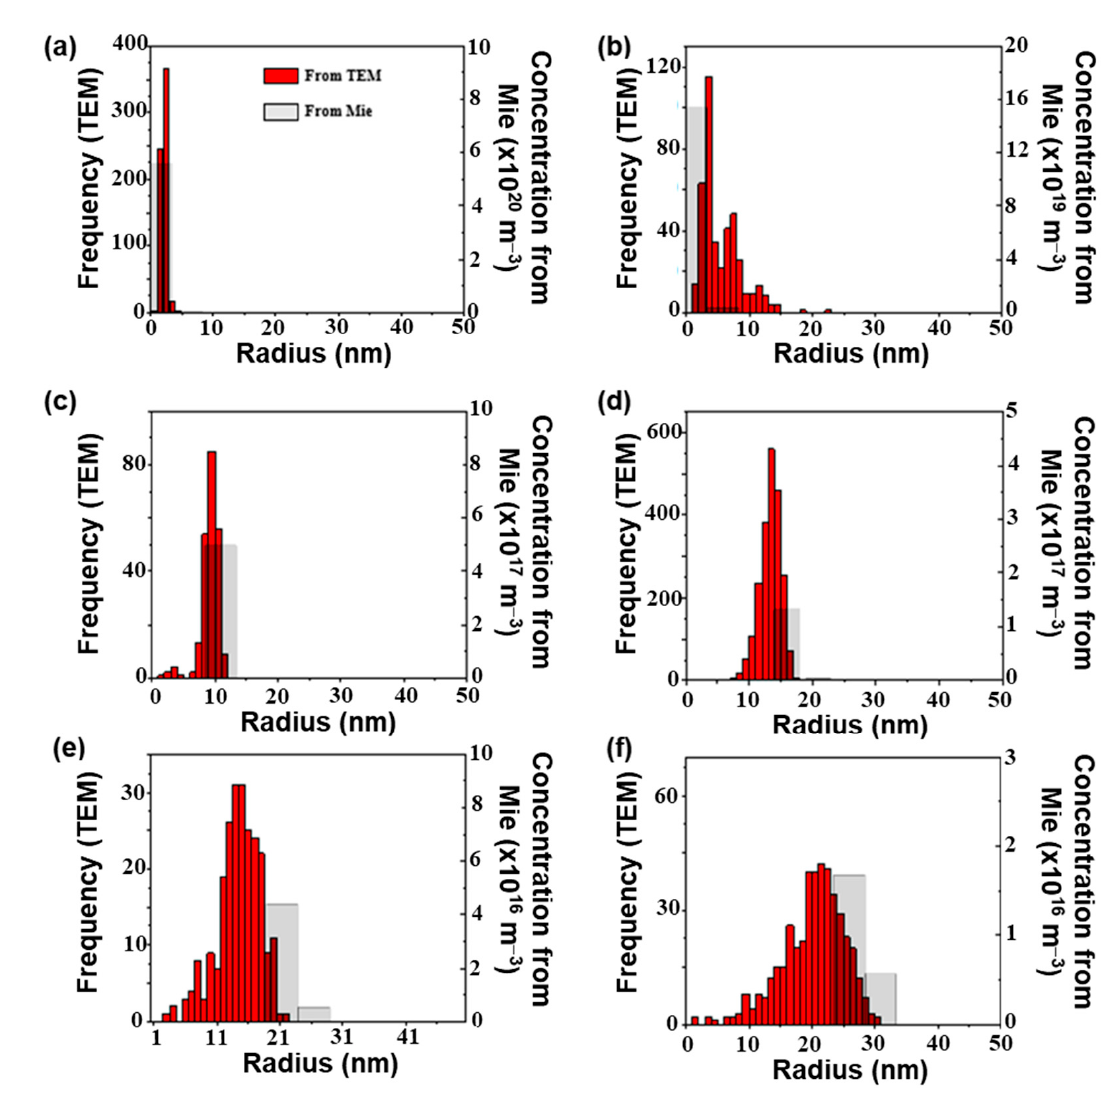
Figure 5. Comparison between the size distributions determined by TEM (in red) and extinction spectroscopy (in grey) of